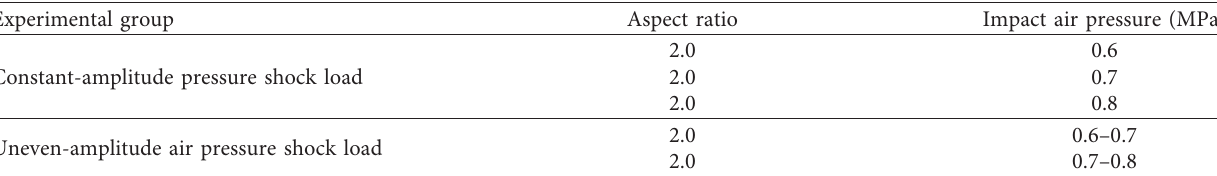
Figure 5: Schematic diagram of the SHPB test system and testing equipment [36]. Table 1: Scheme of the impact